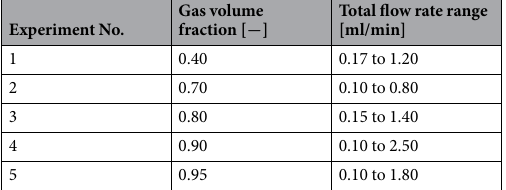
Table 1. Summary of the experiments with varying total